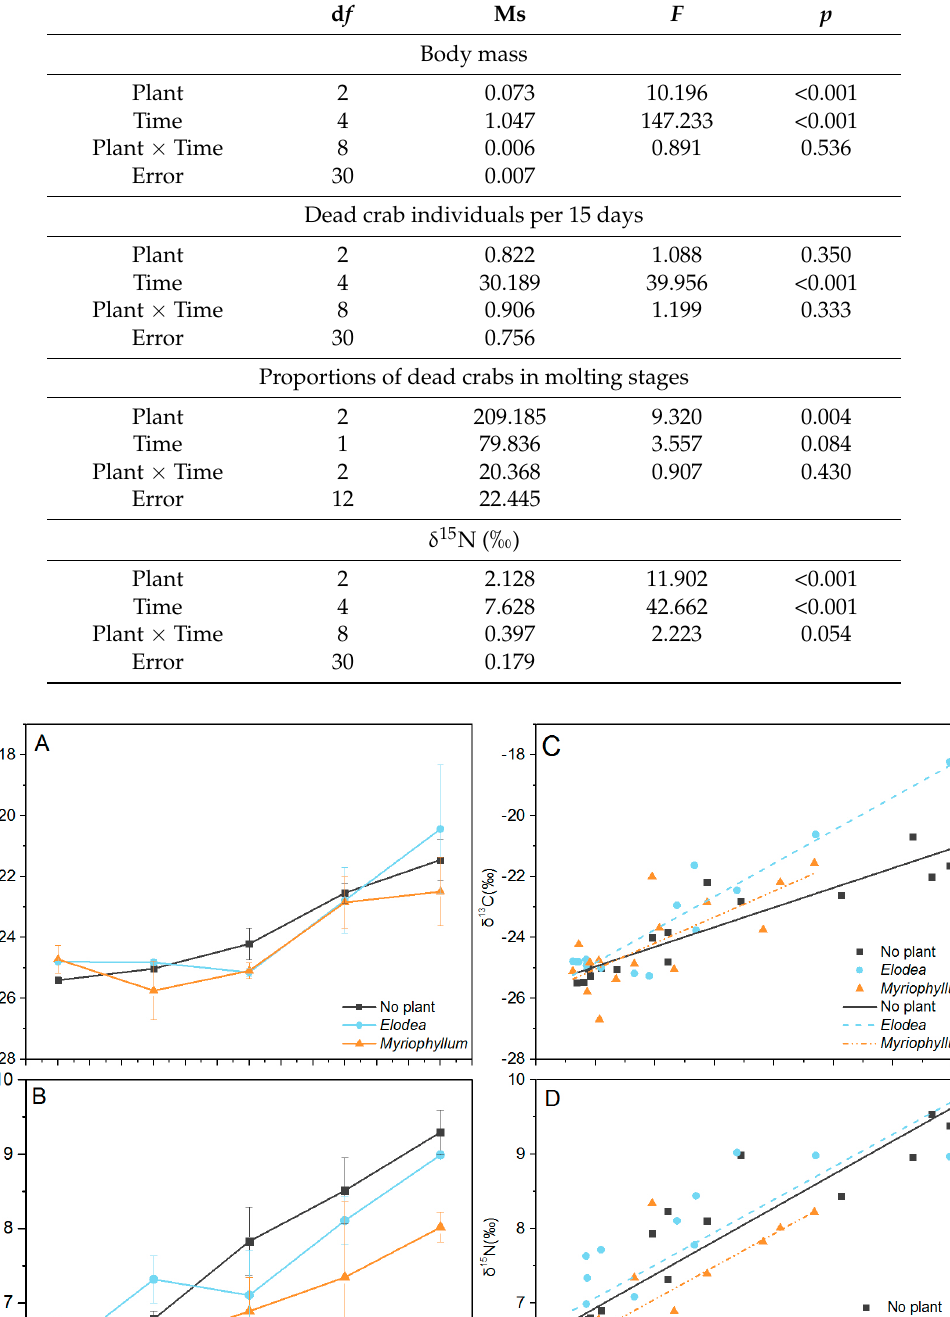
Table 3. Summary of two-way ANOVA results in the cannibalism experiment.